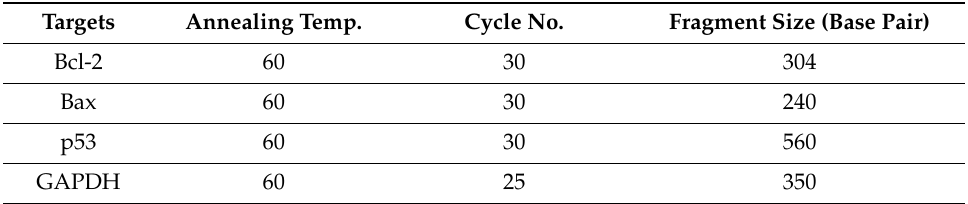
Table 1. The experimental conditions of the semi-quantitative RT-PCR in this study. Targets Annealing